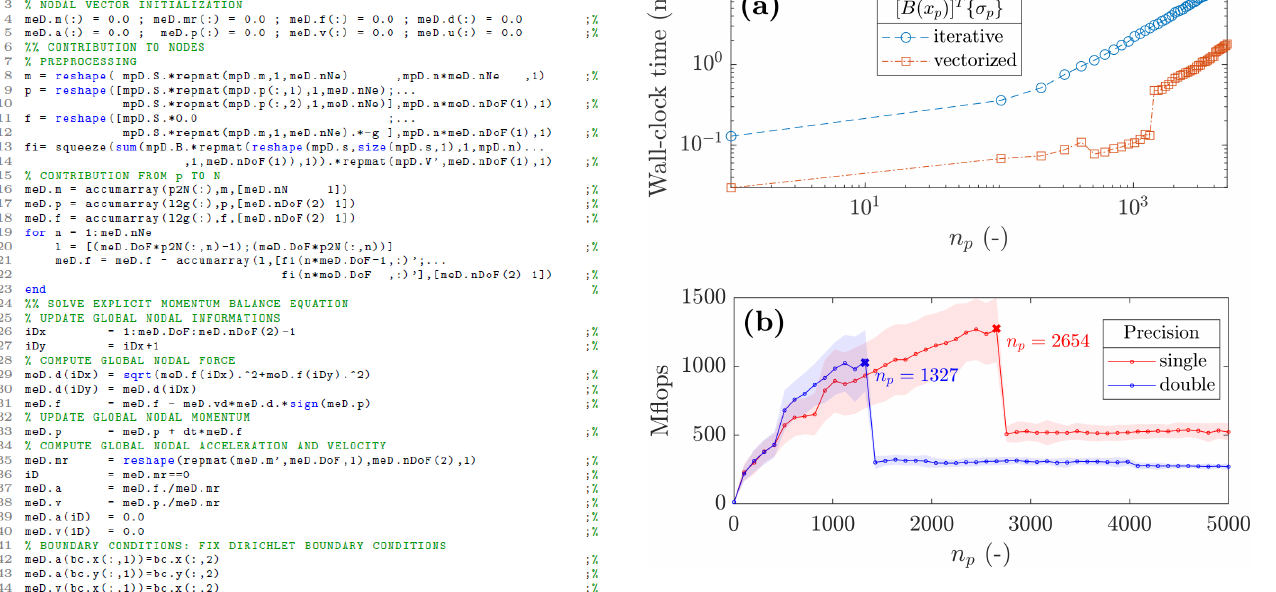
Figure 6. (a) The wall-clock time to solve for a matrix multiplica- tion between a multidimensional array and a vector with an increas- ing number of the third dimension with a double arithmetic pre- cision, and (b) the number of floating point operations per second (flops) for single and double arithmetic precisions. The continuous line represents the average values, and the shaded area denotes the standard